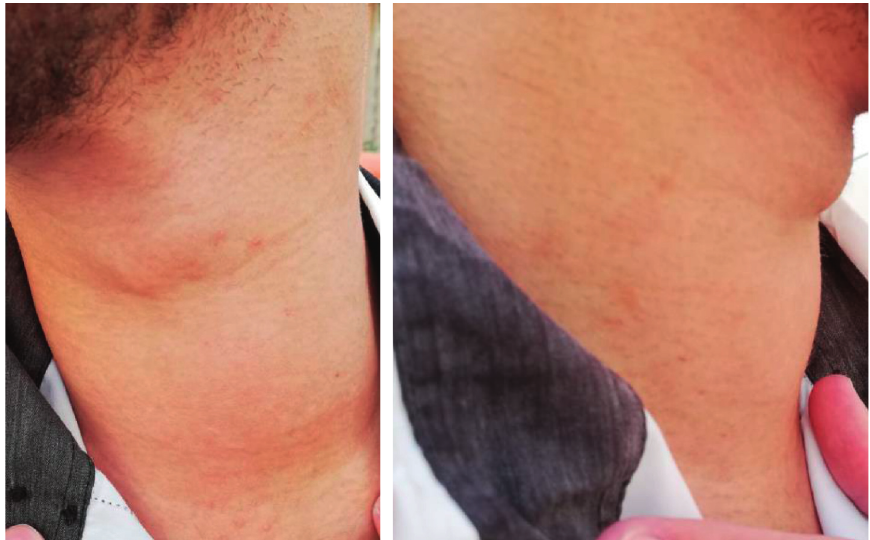
Figure 1: Physical neck examination photographs show enlargement of the thyroid